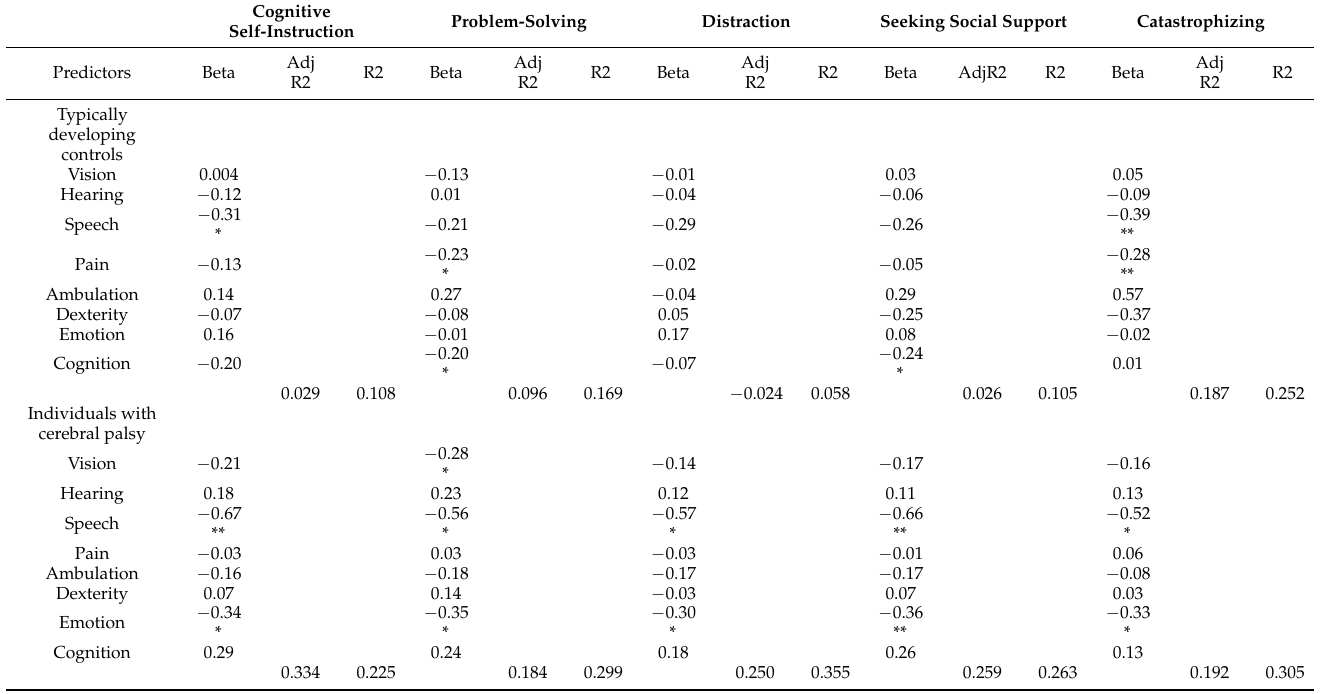
Table 5. Multiple regression predictors of pain-coping strategies related to health domains in individ- uals with cerebral palsy and controls with typical